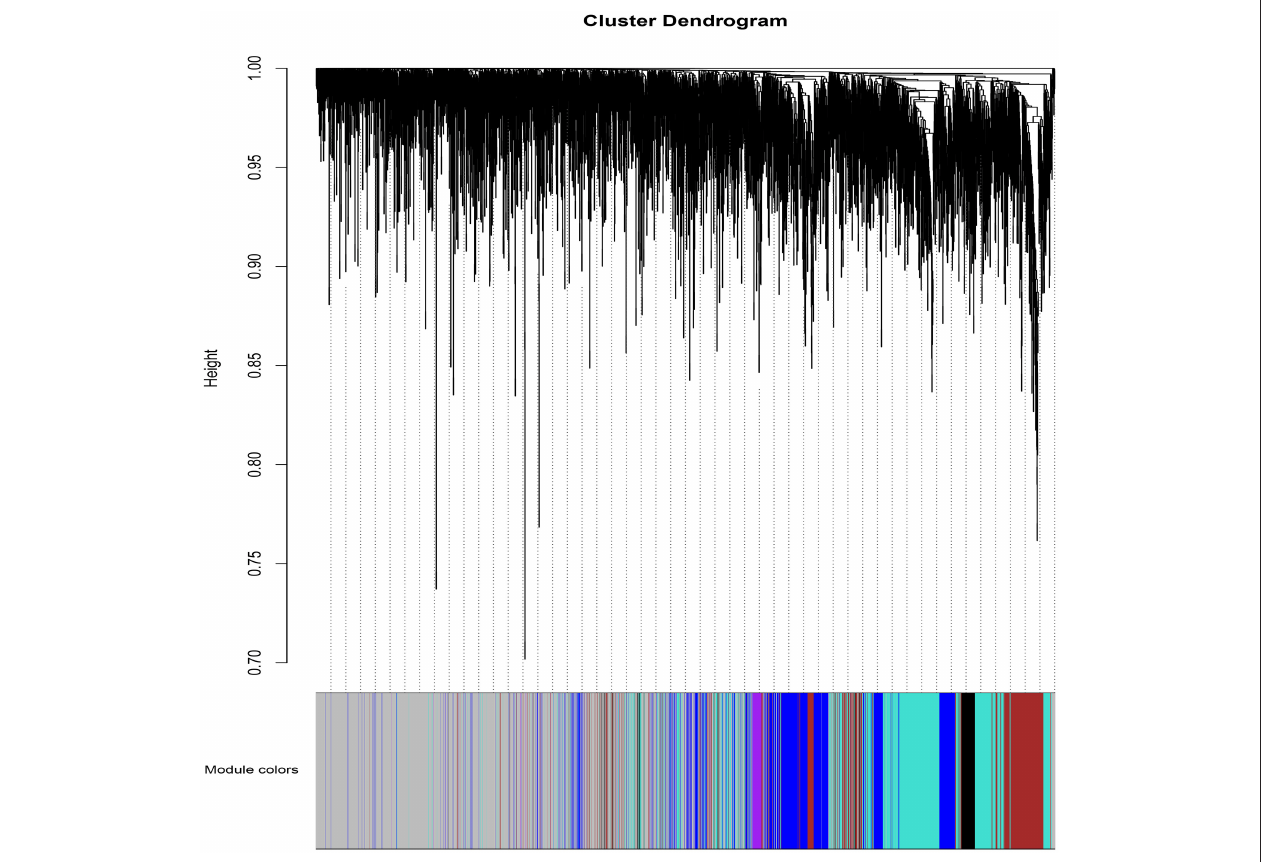
FIGURE 2 | The dendrogram of dissimilarity TOM Matrix constructed using hierarchical clustering. Each vertical line corresponds to the gene. Module colors are provided at the bottom. Each color corresponds to the separate genes module.